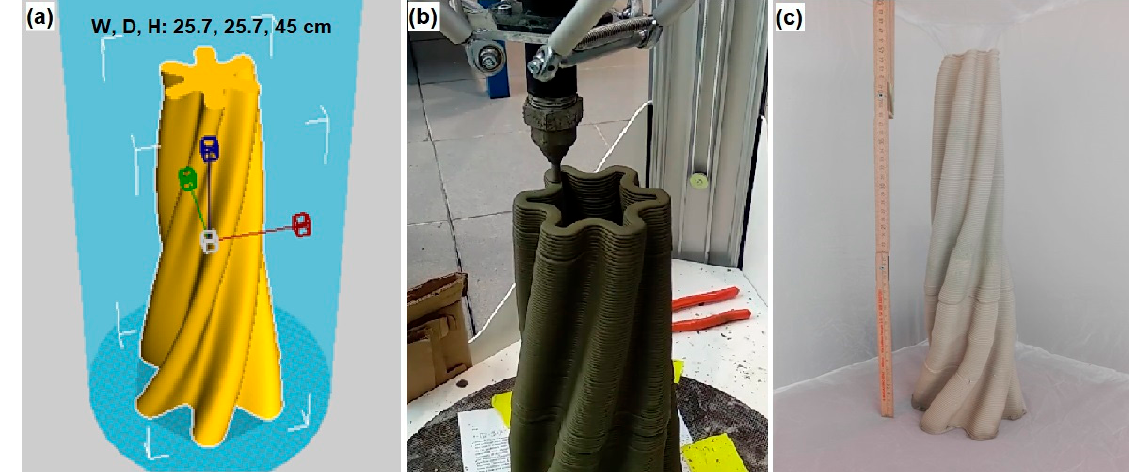
Figure 8. Scale-up process. ( a ) 3D model of the printed object (“W” stands for width, “D” depth, “H” height); ( b ) printing process; ( c ) final result, after 28 days of curing at ambient temperature.